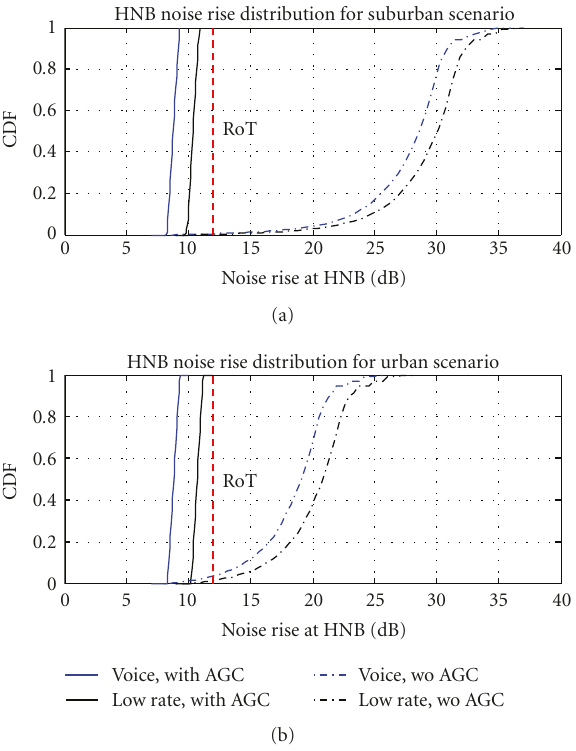
Figure 3: Distribution of rise over thermal (RoT) in a femtocell with nonconnected UE